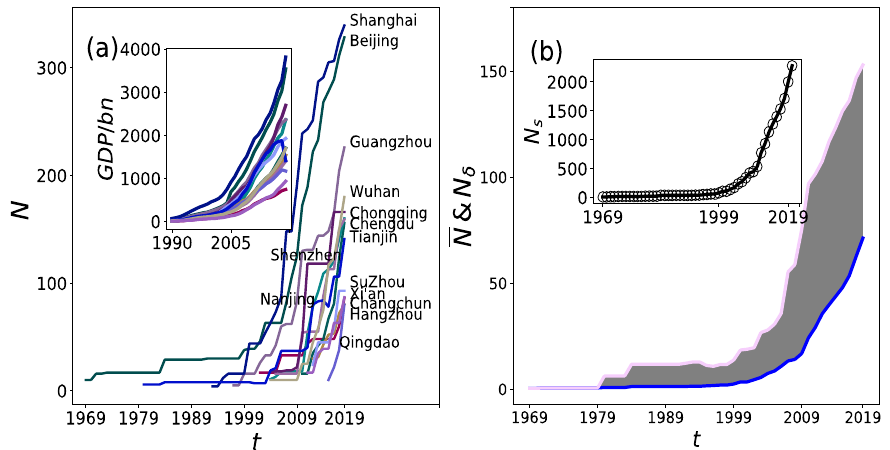
Figure 2. ( a ) Evolution of the network size for 14 large metro networks and GDP from 1990 corresponding to each city. ( b ) The blue curve and pink curve indicate the average number of stations N and the standard deviation ( N σ ) across all metro networks, respectively. The summary of stations ( N s ) in year t aggregated by all networks presented in the inset.